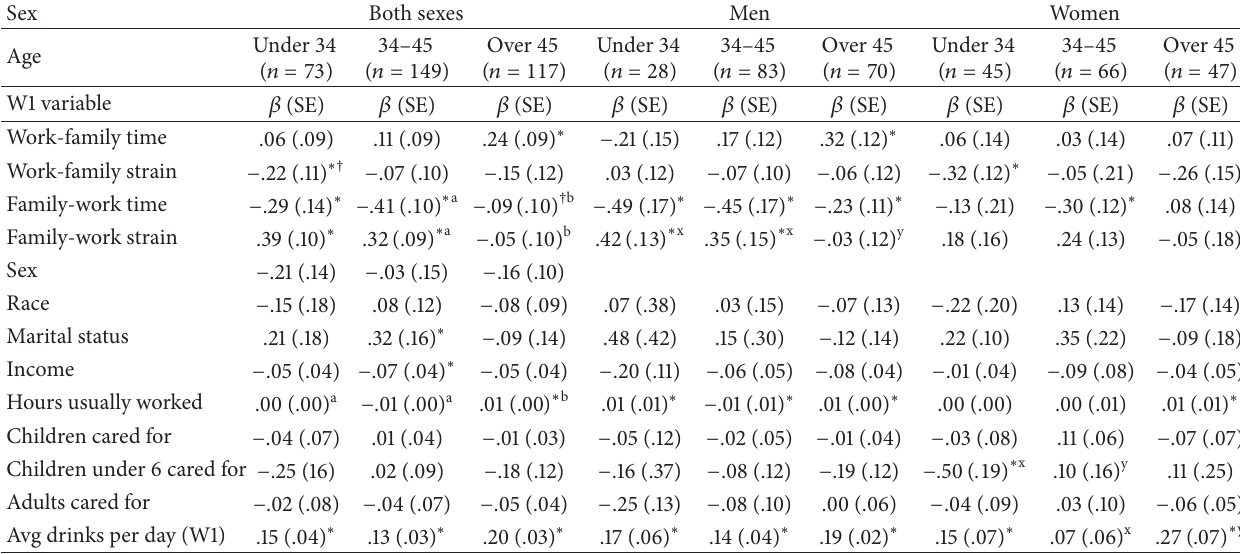
Table 2: Unstandardized regression results predicting average number of drinks per day